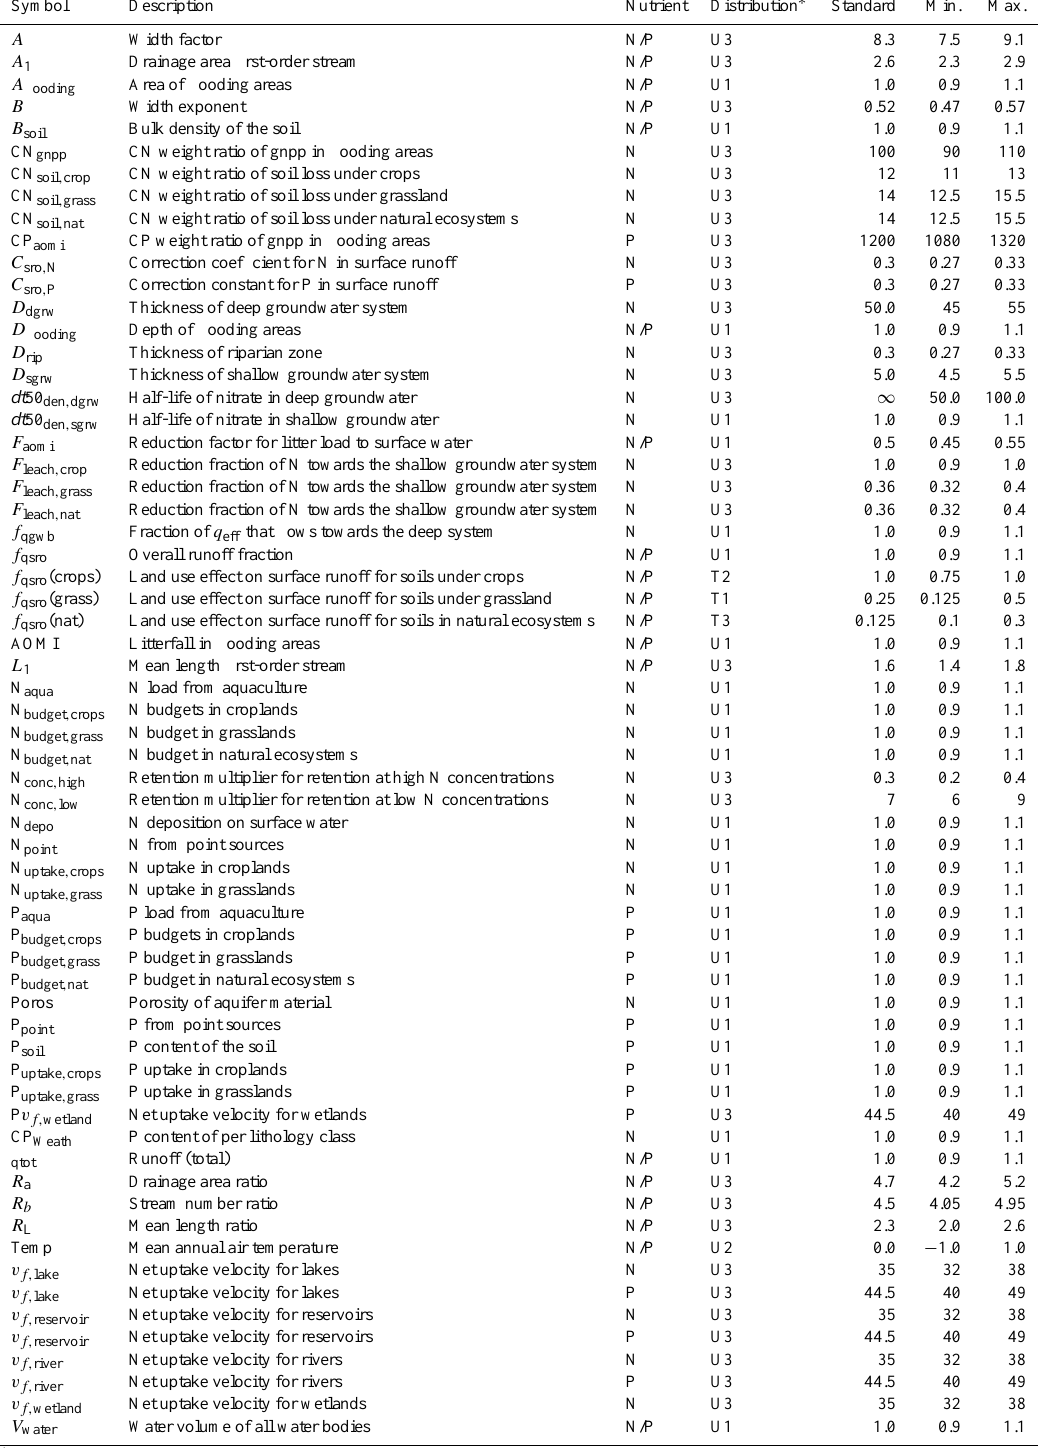
lowerlimit a ,upperlimit b andmode c ,where a ≤ c ≤ b .Theprobabilitytosampleapointdependsontheskewnessofthetriangle.Inthecaseof dt 50 den , dgrw , ac = bc ,and probabilitytosampleapointontheleftandrighthandsideof c isthesame.Inothercases,forexample, f qsro (crops)isafraction(range = [0,1]),withstandardvalueof1.0.Toachieve ahighprobabilitytosamplecloseto1.0,thetriangleisdesignedwith b = 1 and c iscloseto1.Forsomeoftheabovedistributionstheexpectedvalueisnotequaltothestandard.Since thecalculated R 2 foralloutputparametersexceeds0.99,thisapproachforanalyzingthesensitivityisstillvalid.ThedistributionsusedareU1.Uniform;valuesaremultipliersfor standardvaluesonagridcellbasis.U2.Uniform;valuesareaddedtothestandardvaluesonagridcellbasis.U3.Uniform;valuesareusedassuch.T1.Triangular;valuesbetween 0.125and0.5withanexpectedvalueof0.25.T2.Triangular;valuesbetween0.75and1.0withanexpectedvalueof0.995.T3.Triangular;valuesbetween0.1and0.3withanexpected